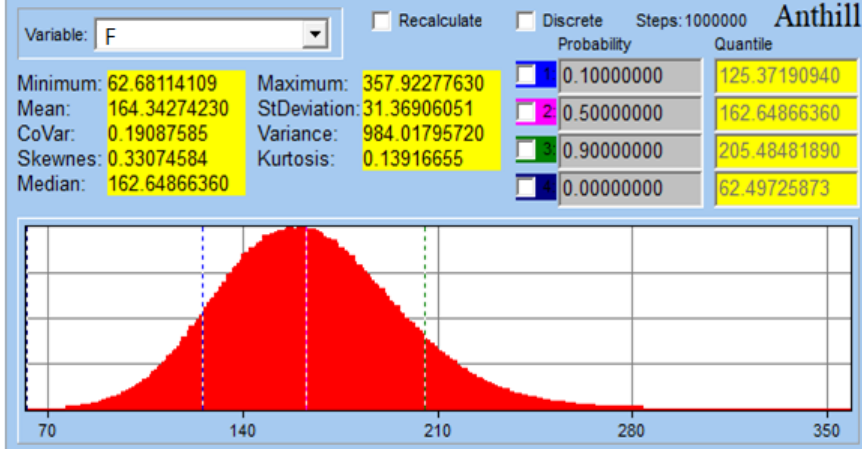
Figure 8. Histogram for axial normal force F in the headless screw (minimum = 62.7 N, median = 162.6 N, mean = 164.3 N, maximum = 357.9 N)—Anthill software.